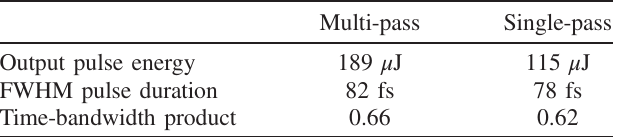
TABLE III. Overview of 60 nm output radiation simulations. For the multipass HGHG the pulse energy and FWHM pulse duration are the average ones in the stable regime of the oscillator. The time-bandwidth product is calculated at the 65th